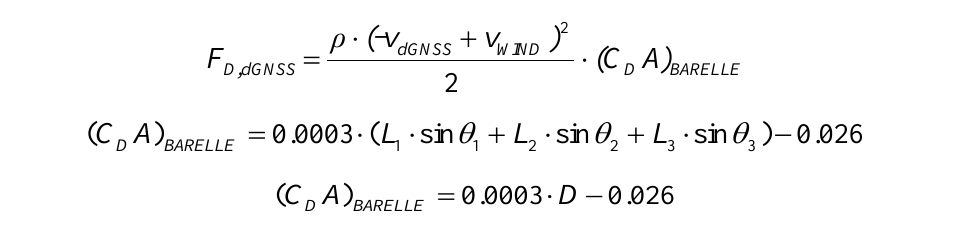
Figure 3. ( a ) Illustration of the reduced skier amplitude (D) applied for the drag area calculation. P (  ), intersection point of the pendulum and the snow surface ( P GNSS ( b ) Illustration of the ski friction force ( F the vertical projection of the velocity vector ( v finally calculated by projection of the ground reaction ( F